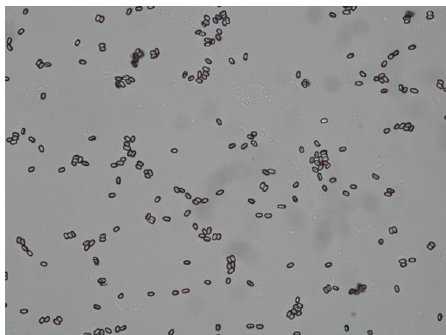
Figure 5. Microscopic image of oval-shaped Nosema- spores. (unstained, 400x) Differentiation of the species is not possible under the microscope. ©Heike Aupperle-Lellbach.